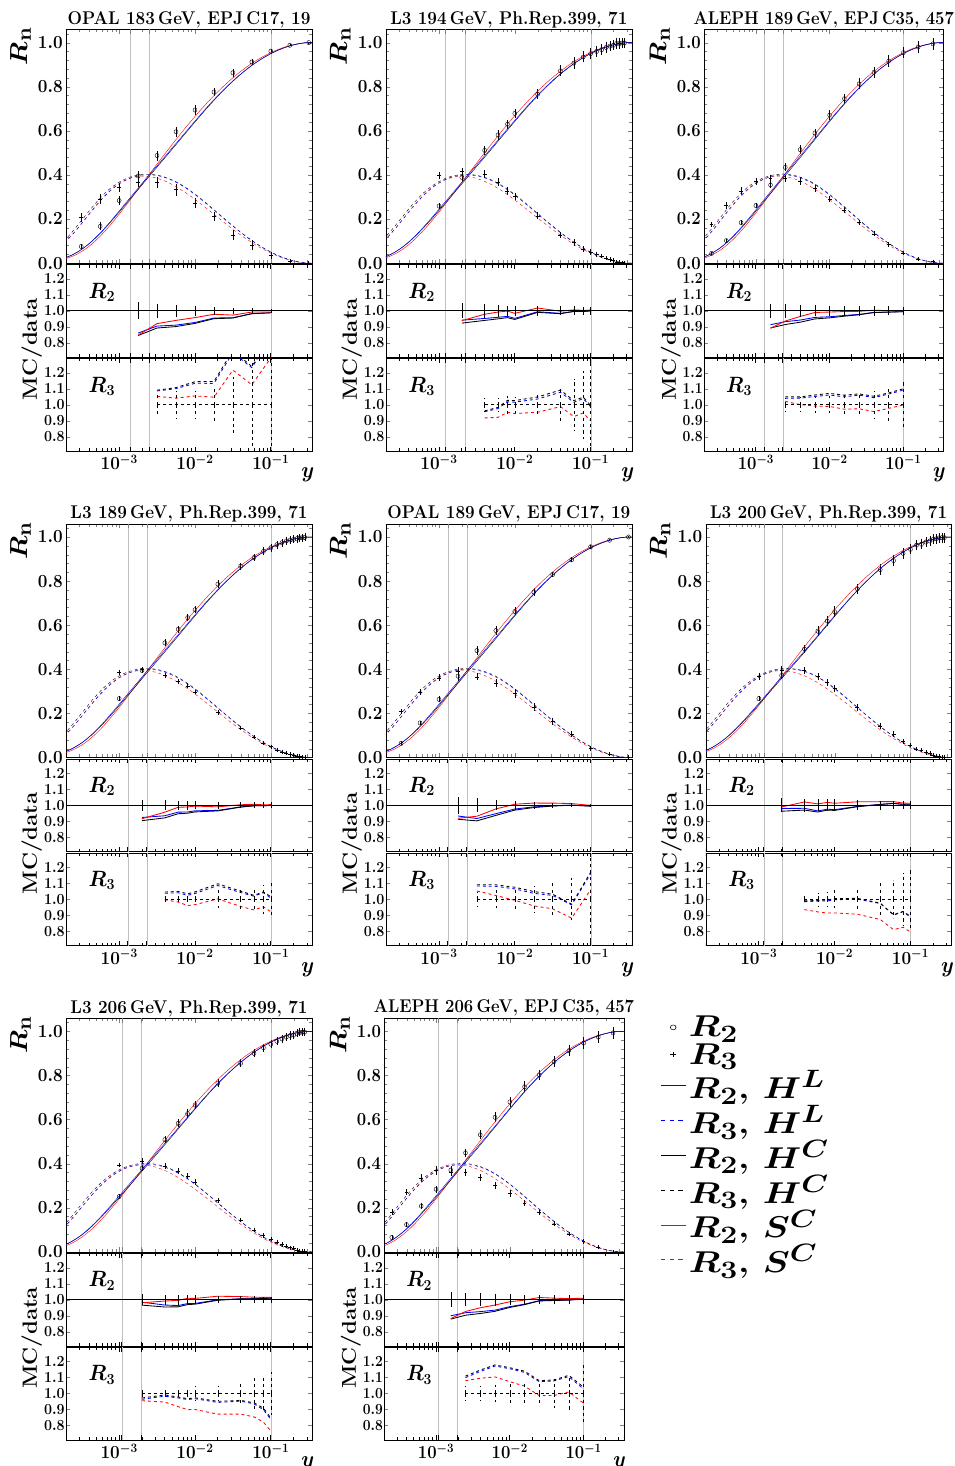
Figure 11 . Predictions obtained with S C , H C and H L MC setups at hadron level.